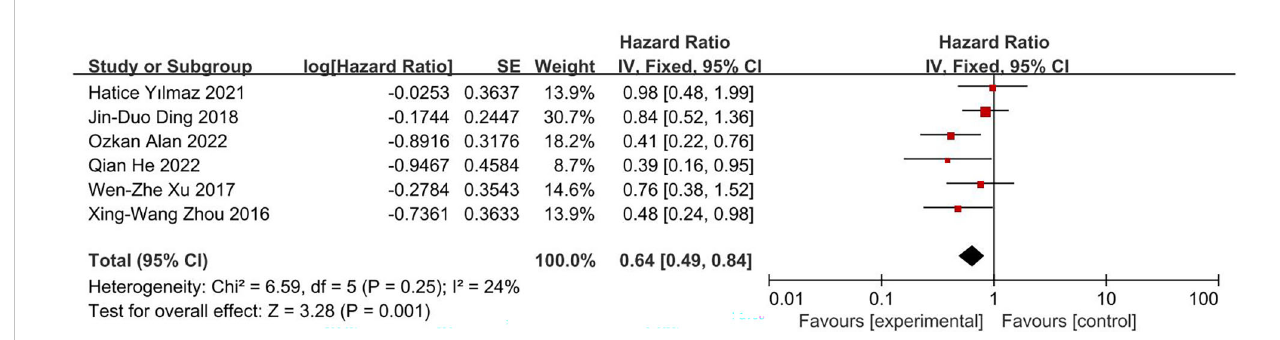
FIGURE 3 Forest plot of correlation between PNI score and OS in multivariate analysis data.